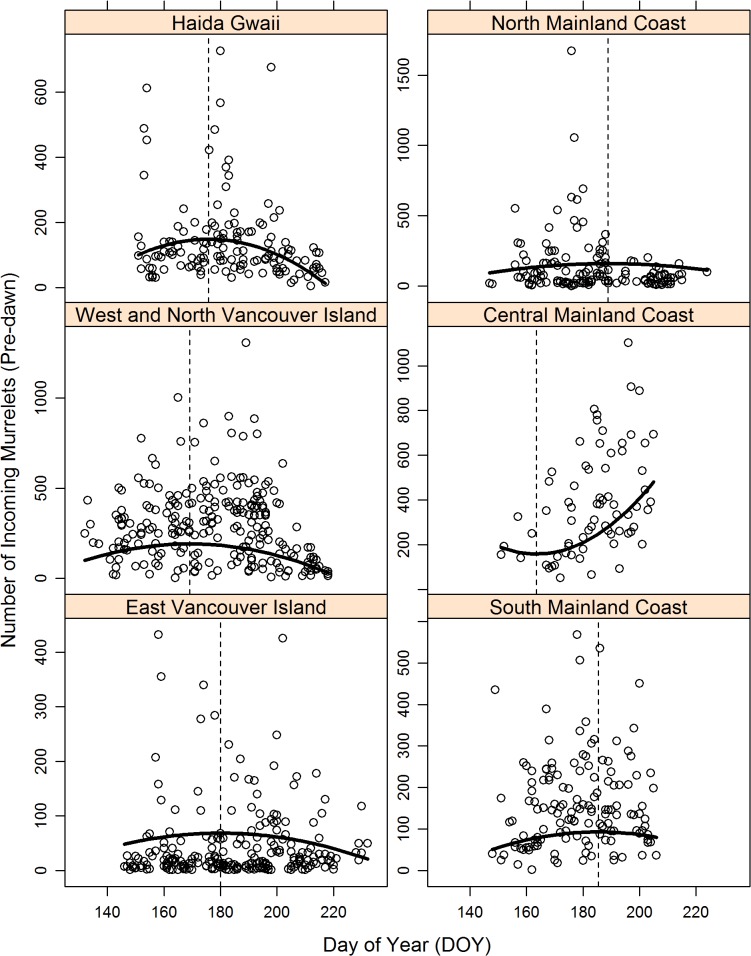
Variation in the number of Marbled Murrelets counted at radar stations in British Columbia, 1996–2013, as a function of Day of the Year (DOY), in six Marbled Murrelet Conservation Regions of British Columbia.Curved line for Day of Year plot shows quadratic relationship suggesting that, on average, highest counts are recorded between days 175–195 (June 18- July 8), with the exception of Central Mainland Coast, where peak counts occurred on July 24.